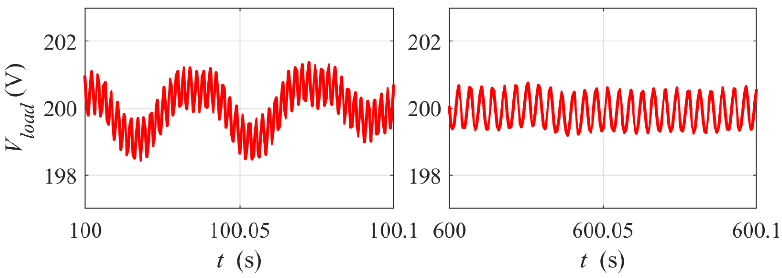
Figure 7. Rippling of the load voltage. Zoomed-in view of V load waveform from Figure 6 at time t = 100 s and t = 600 s.